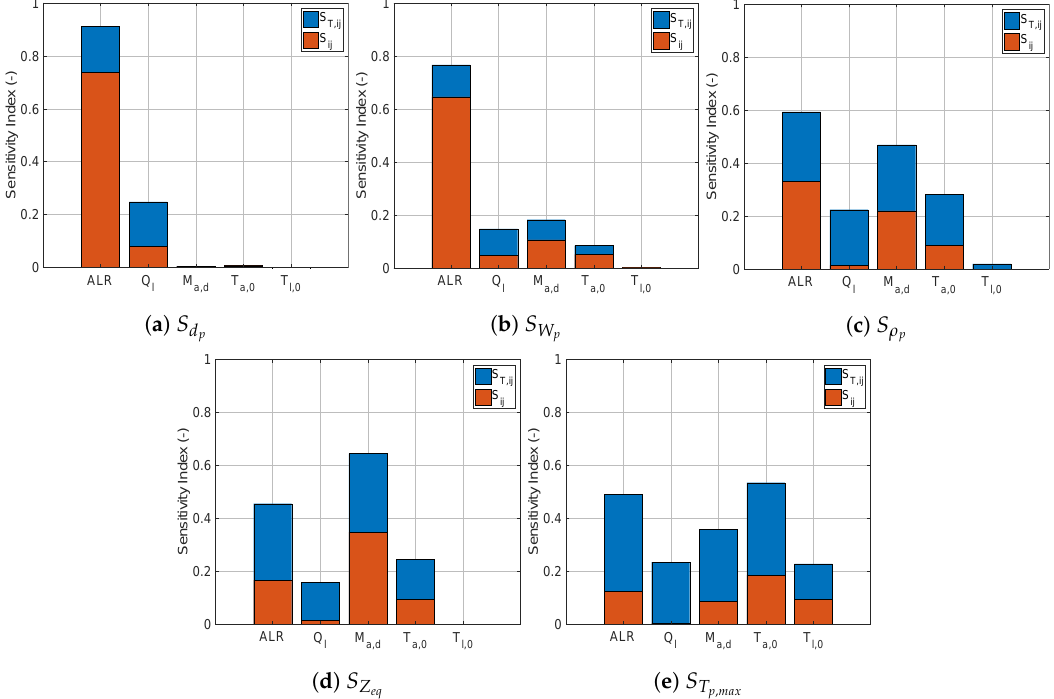
Figure 6. Sensitivity indices ( S i , S T , i ∀ i ∈ { d p , W p , ρ p , Z eq , T p , max } ) for the spray dryer operating with a pneumatic nozzle calculated using fourth order PCE with 600